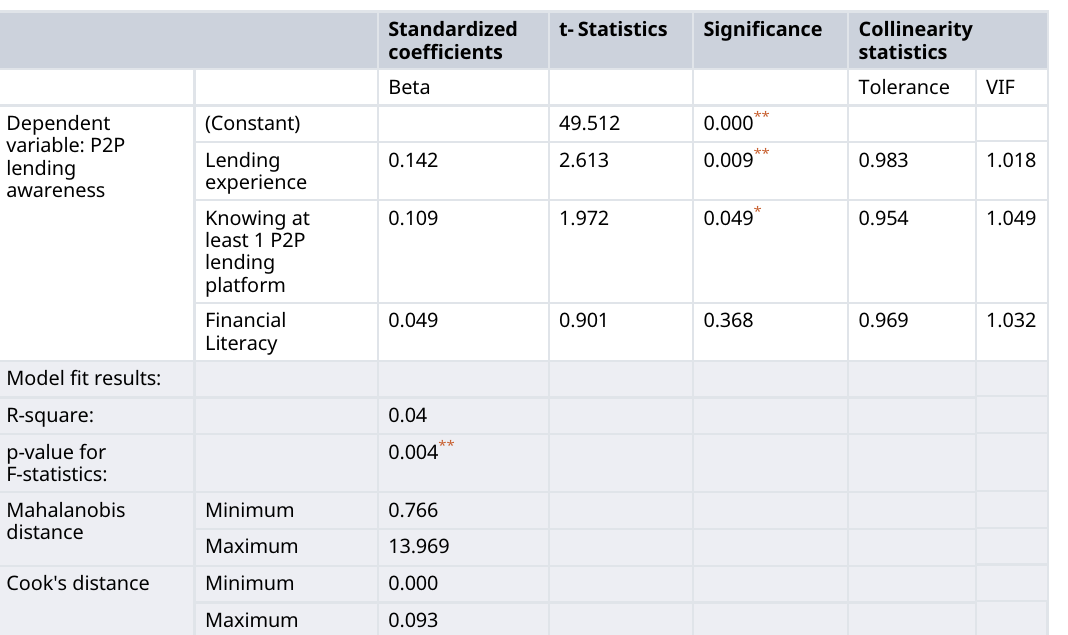
Table 6. Multiple regression